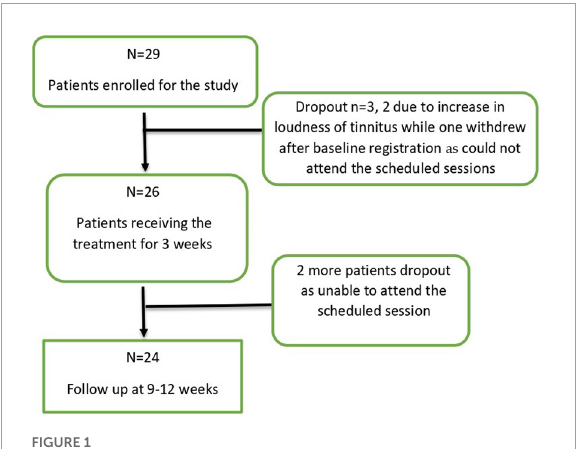
FIGURE1 Consort flow diagram for patients’ enrollment and data analysis.